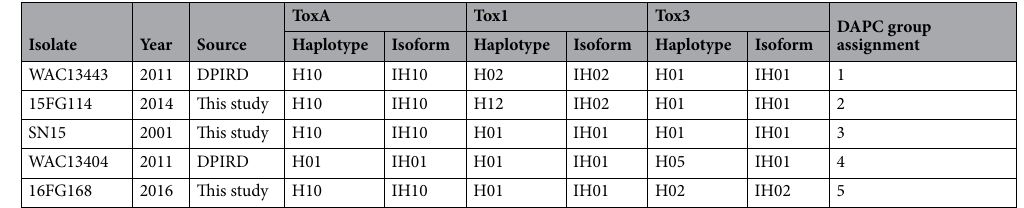
Table 1. Australian Parastagonospora nodorum isolates (Phan et al. 2020) used in this study.